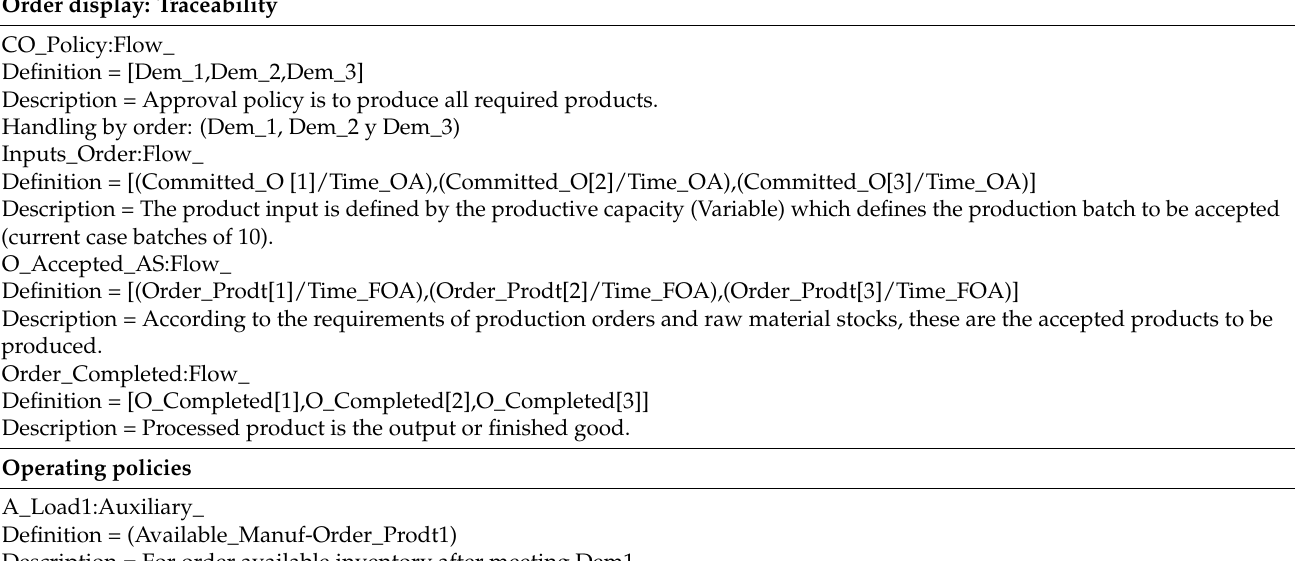
Table 4. Mathematical equations in data flow